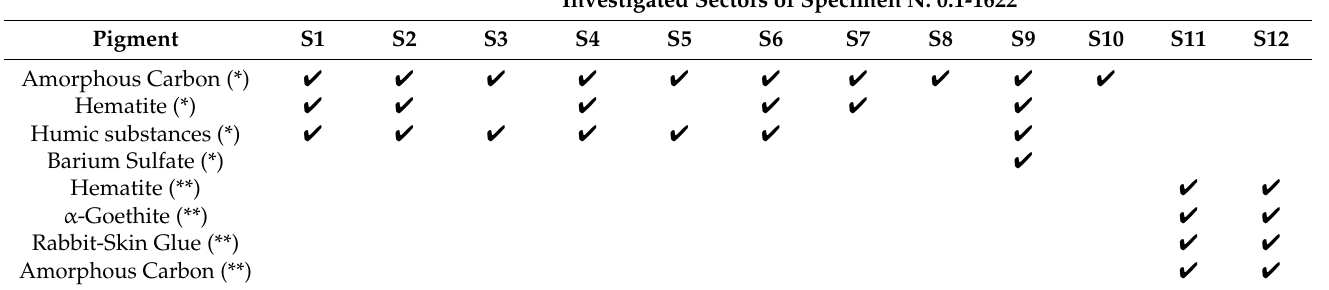
Table 1. List of the identified species in each sector labeled as S1, S2, S3, S4, S5, S6, S7, S8, S9, S10, S11, and S12 belonging to specimen N. 01.1622. The data are related to the 514 nm excitation (*) and to the 633 nm excitation